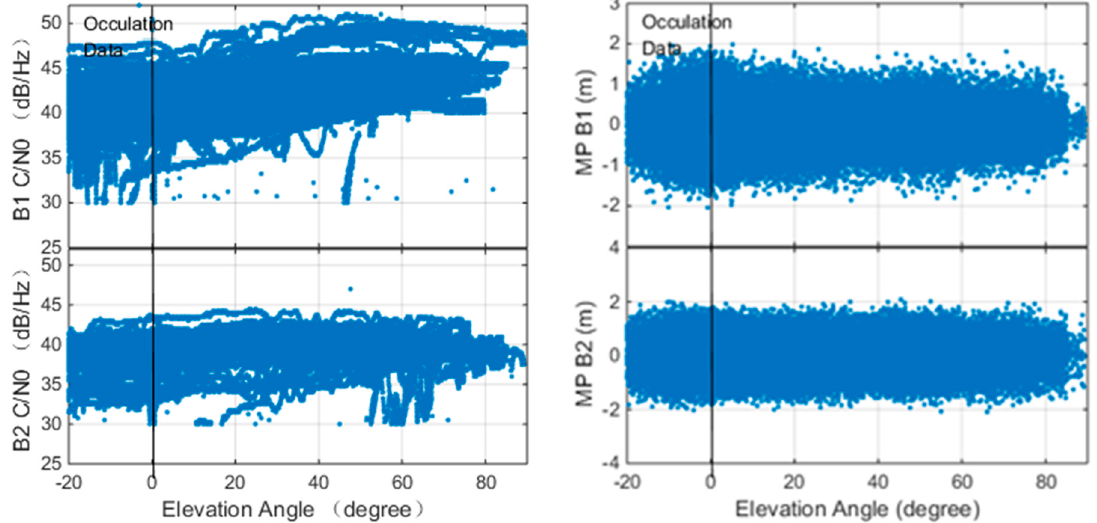
Figure 4. C/N0 ( Left ) and multipath ( Right ) of Luojia-1A onboard Beidou B1/B2 observation.